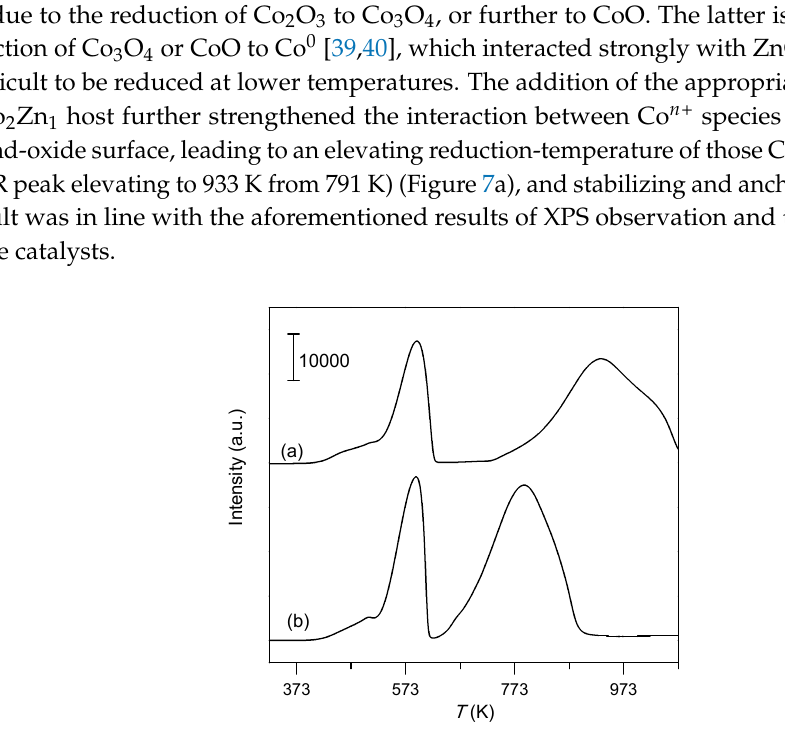
Figure 7. H 2 -temperature-programmed reduction (H 2 -TPR) profiles of the oxide catalysts: ( a ) Co 2 Zn 1 Sc 0.3 ; ( b ) Co 2 Zn 1